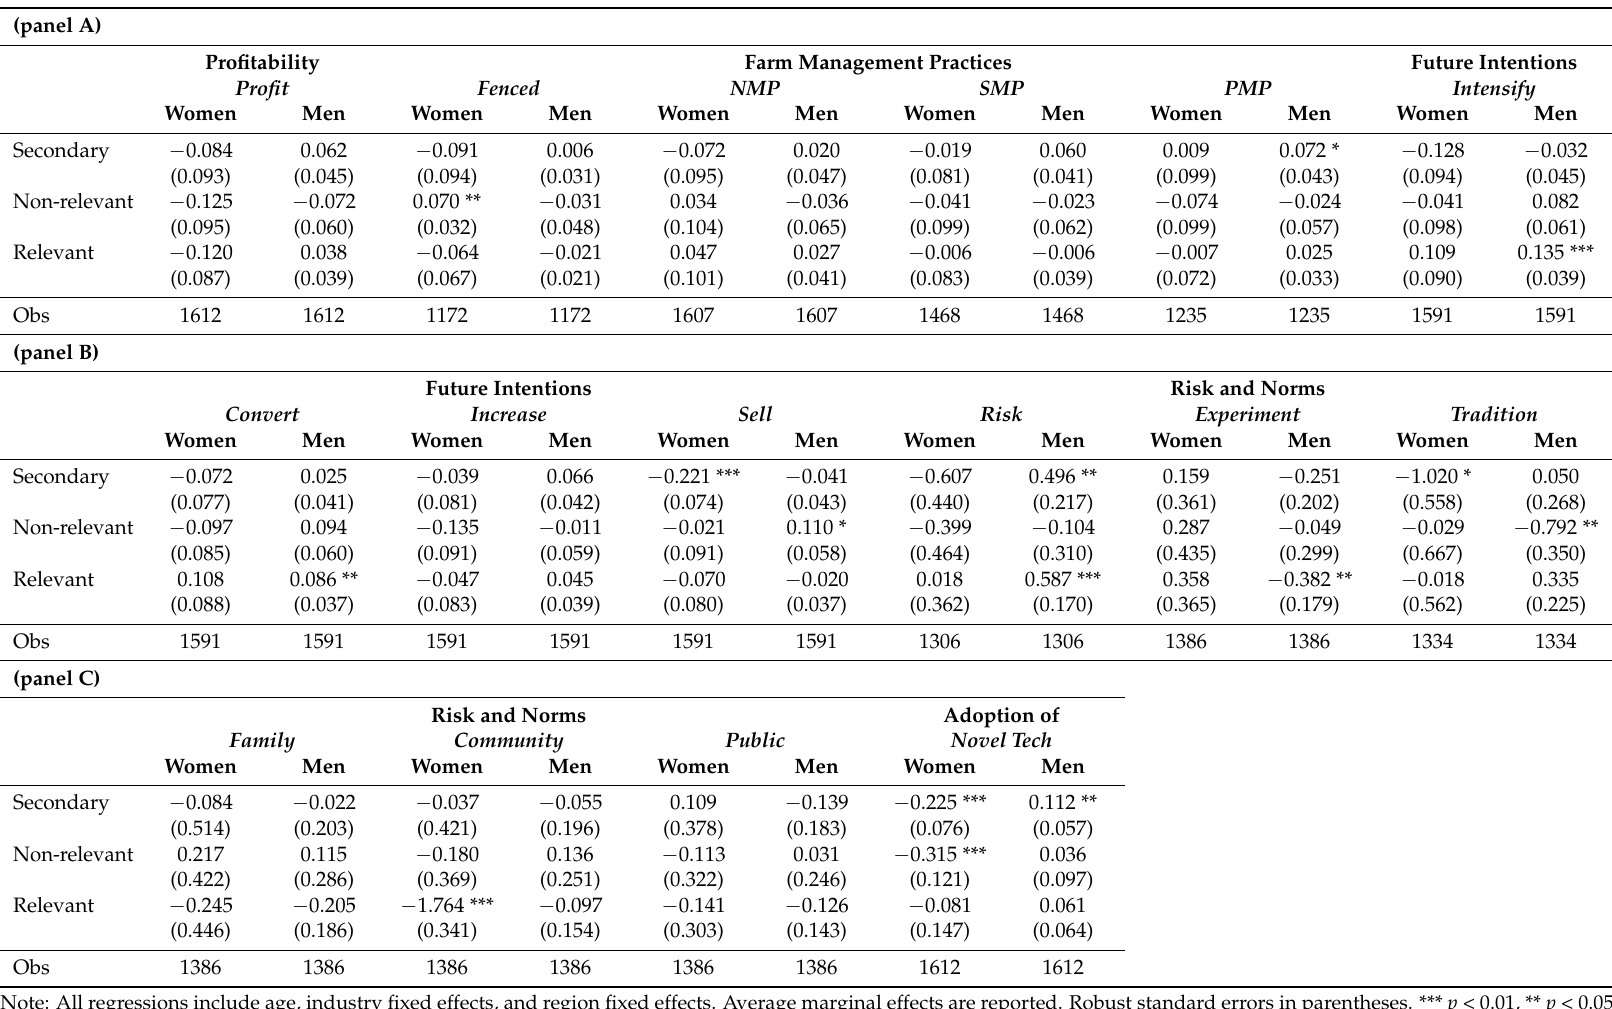
Table 5. Probit, Tobit, and Negative Binomial Regressions with Interactions between Education and